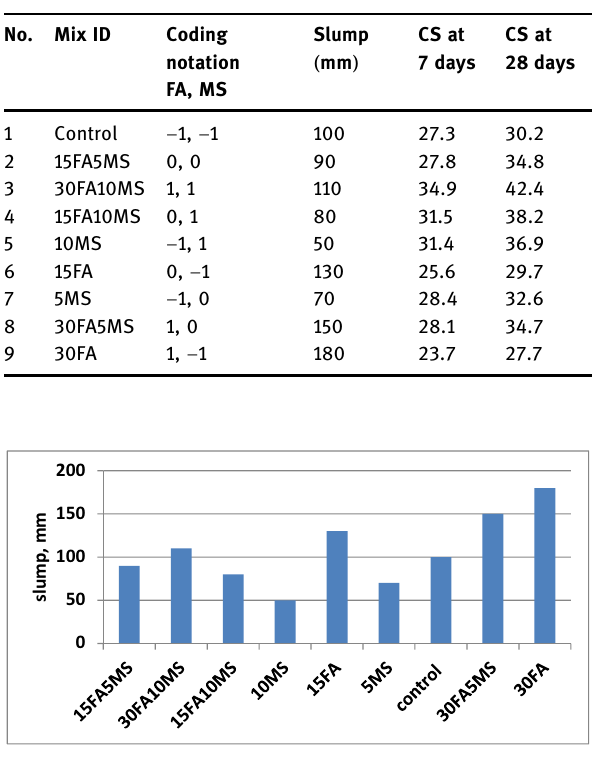
Table 4: Experimental tests results